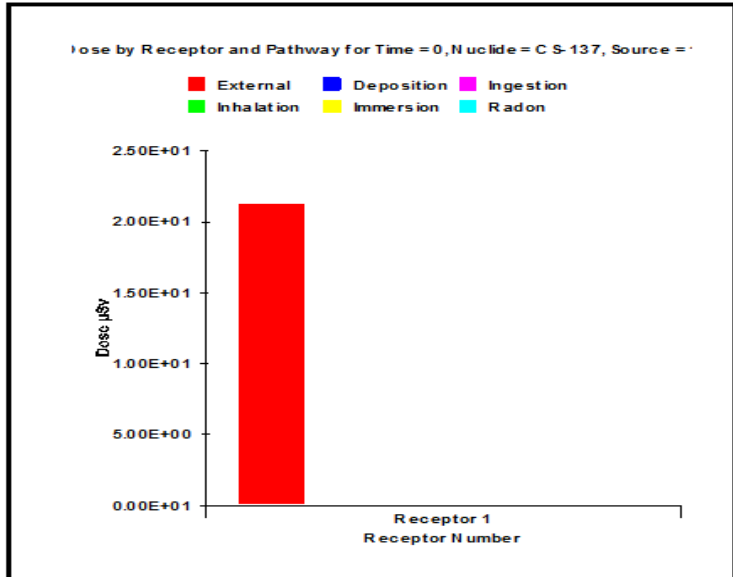
Fig.4: The total dose in equipment